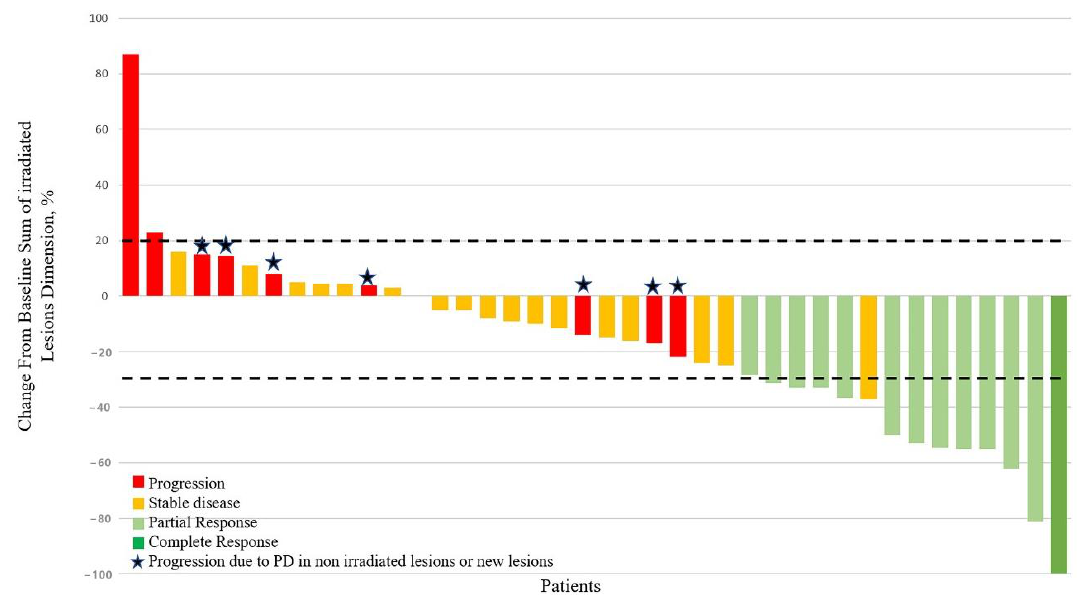
Figure 3. Waterfall plot of the irradiated lesions. Plot shows dimensional change in irradiated lesions as a percentage of the baseline measurement. Lower and upper dashed lines represent the cut-offs for progressive disease (20% increase in the sum of diameters of lesions) and for partial response (30% decrease in the sum of diameters of target lesions), respectively. The colors show the RECIST 1.1 response for all of the disease (including irradiated and non-irradiated lesions). Stars represent patients experiencing disease progression due to new lesions or due to growth in non-irradiated lesions.